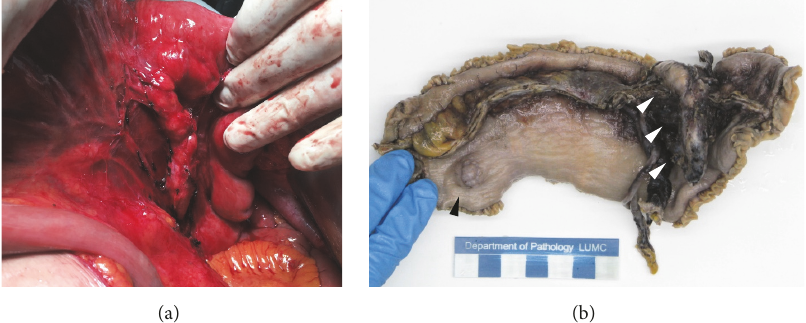
Figure 6: (a) Intraoperative view on the proximal jejunum and its mesentery showing the heterotopic pancreas extending centrally. (b) Gross specimen of the segment resection after the jejunum is opened, demonstrating the heterotopic pancreas (white arrowheads) connected to the jejunum and the second manifestation of heterotopic pancreas in the serosa of the jejunum (black arrowhead) .